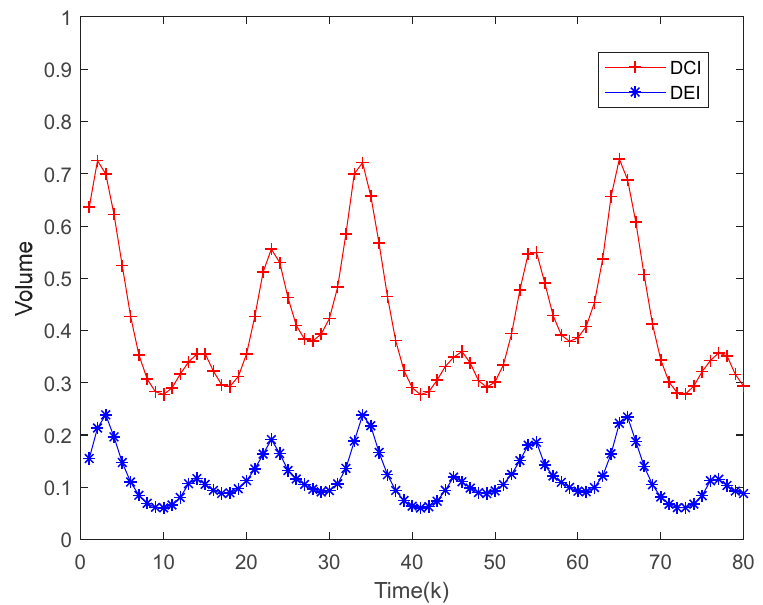
Figure 5. Ellipsoidal volume characterized by the fusion of the DEI and DCI results.